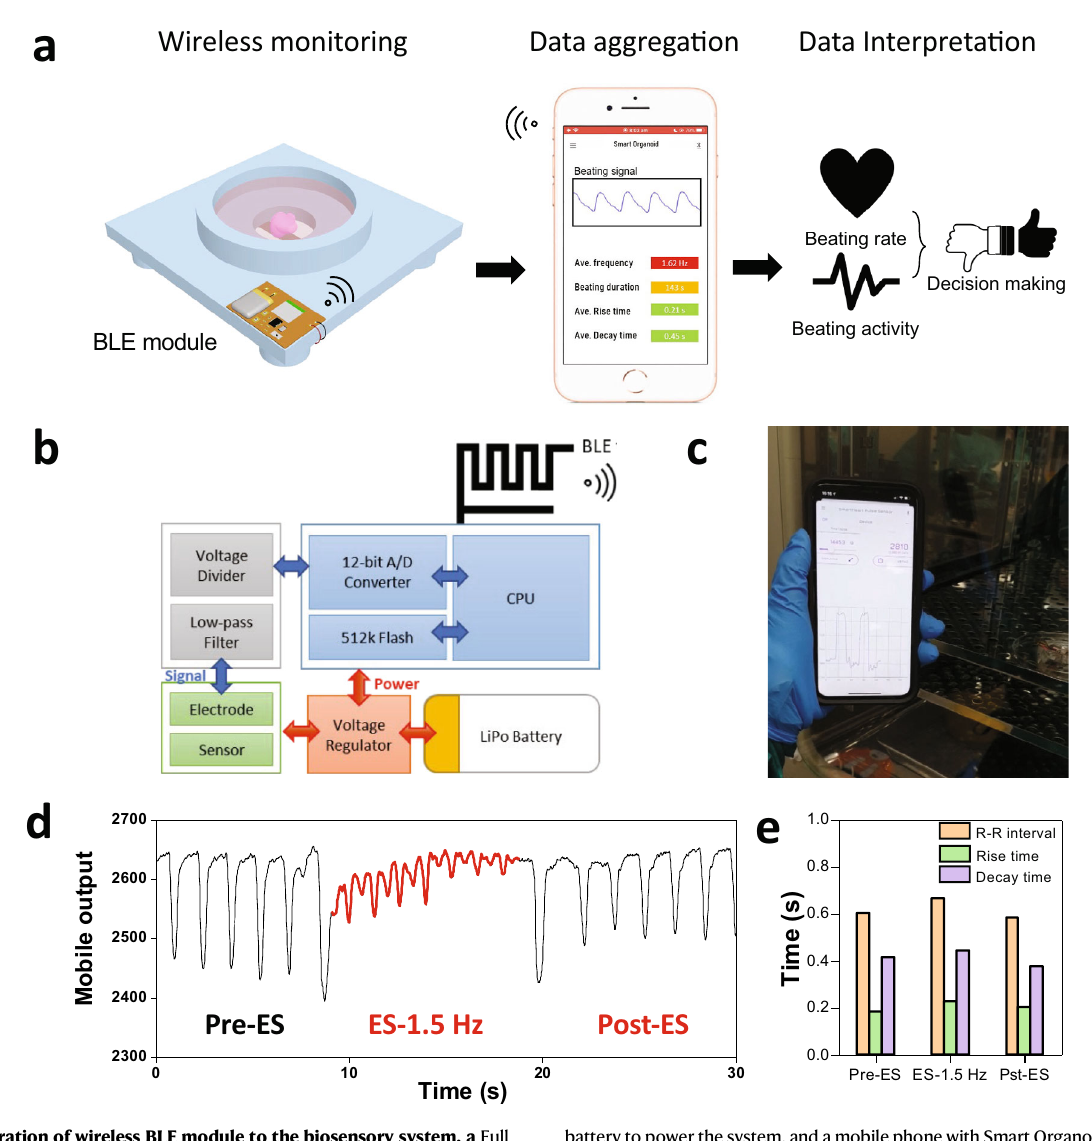
Fig. 6 | Integration of wireless BLE module to the biosensory system. a Full spectrum-procedures of organoid biosensorysystem integrated with wireless BLE modulefor remoteorganoidmonitoring anddecisionmaking. b Blockdiagram of the smart-organoid monitoring system, including the nRF52832 Bluetooth